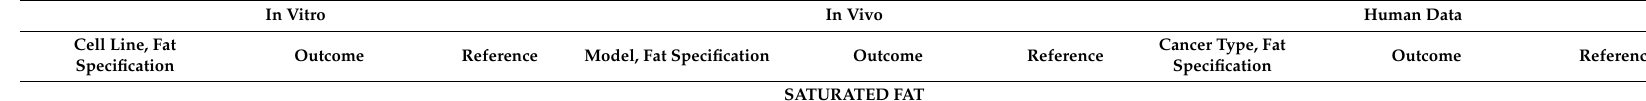
Table 1. Summary of experimental and human data on relation between fat type and